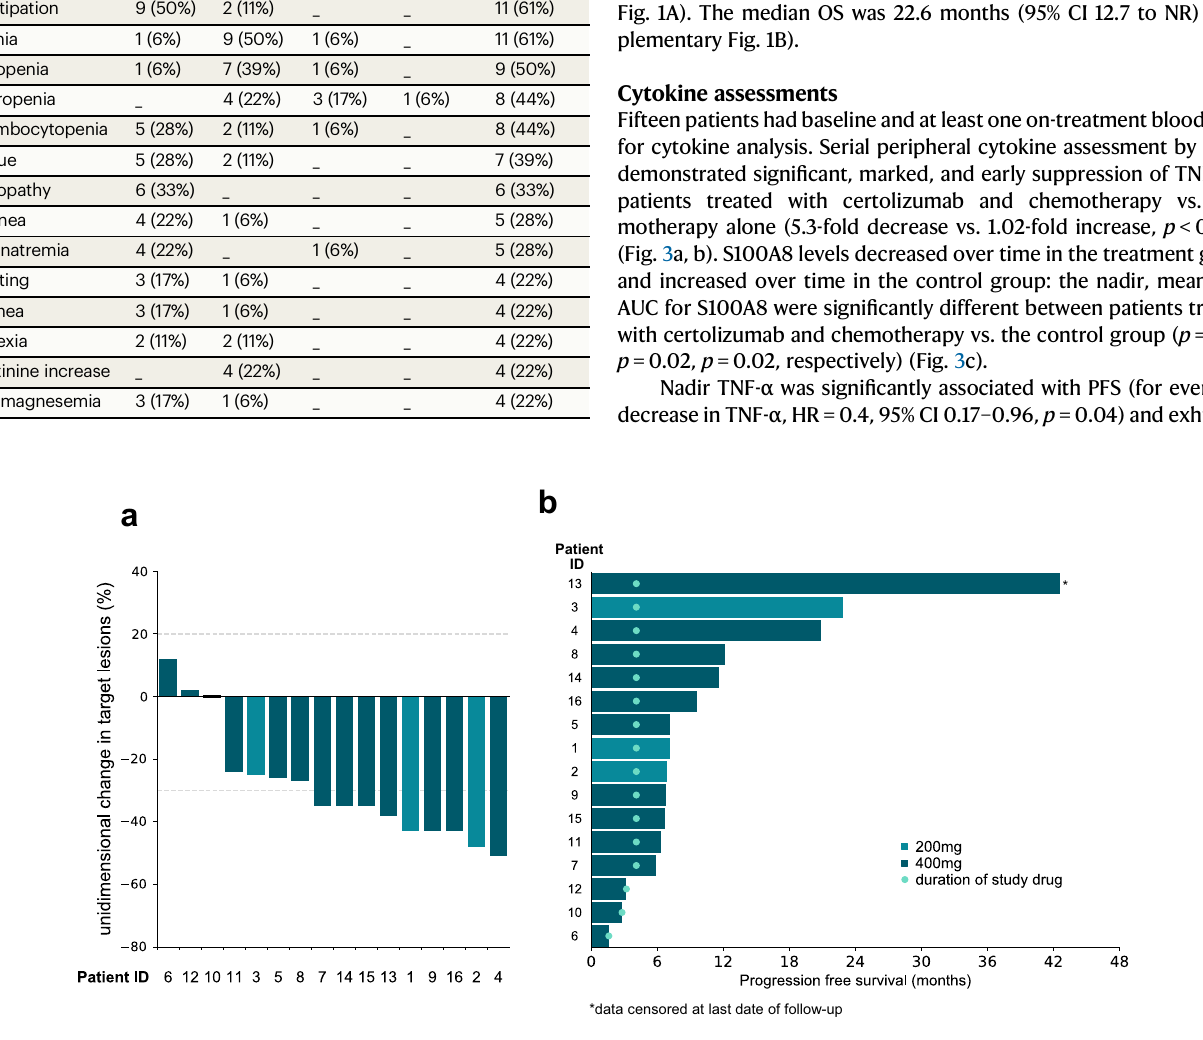
Fig. 2 | Radiographic responsesand progression-freesurvivalfor patientswith advanced lung adenocarcinomas. a Best unidimensional response per RECISTv1.1. b Swimmer plot depicting progression-free survival (PFS) for patients treatedwith cisplatin,pemetrexed,and certolizumab(medianPFS7.1months,95%